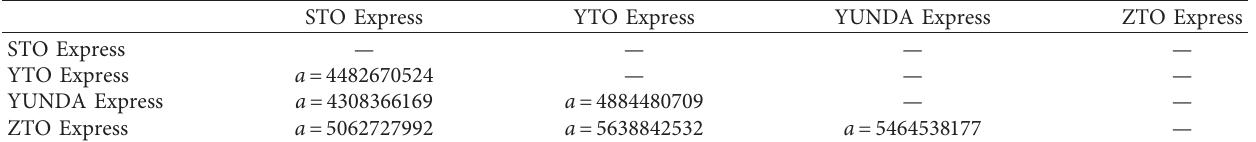
Table 4: Average market size of listed express delivery companies when cooperating two-two. STO Express YTO Express YUNDA